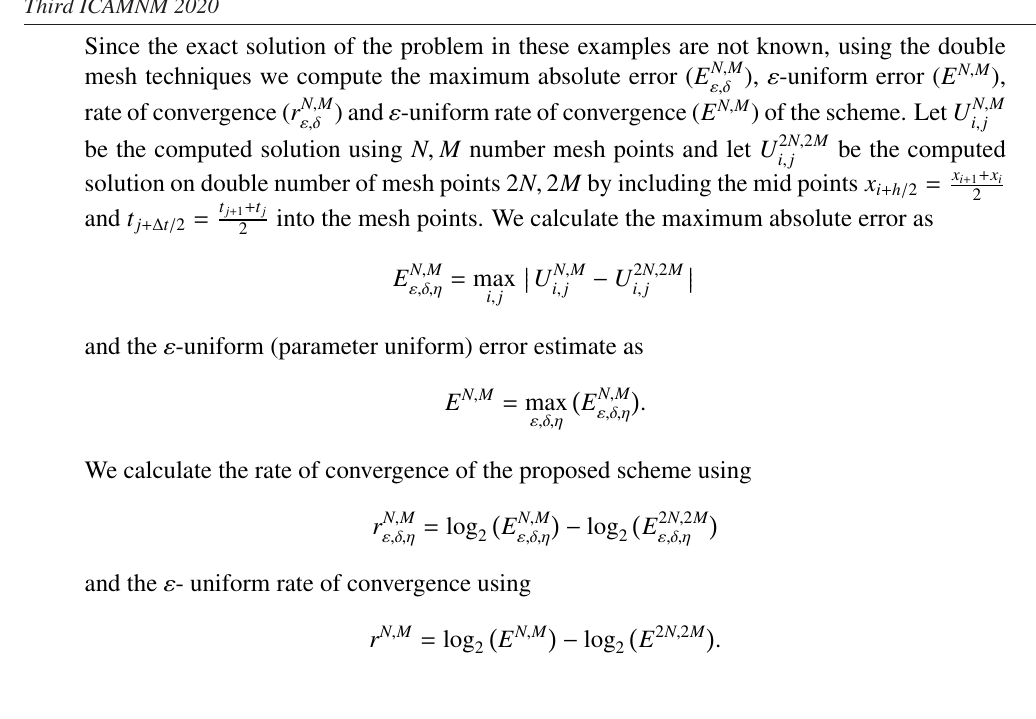
Table 1. Example 4.1, maximum absolute errors of the scheme without exponential fitting factor ( σ ) for δ = 0 . 6 ε and η = 0 . 5 ε